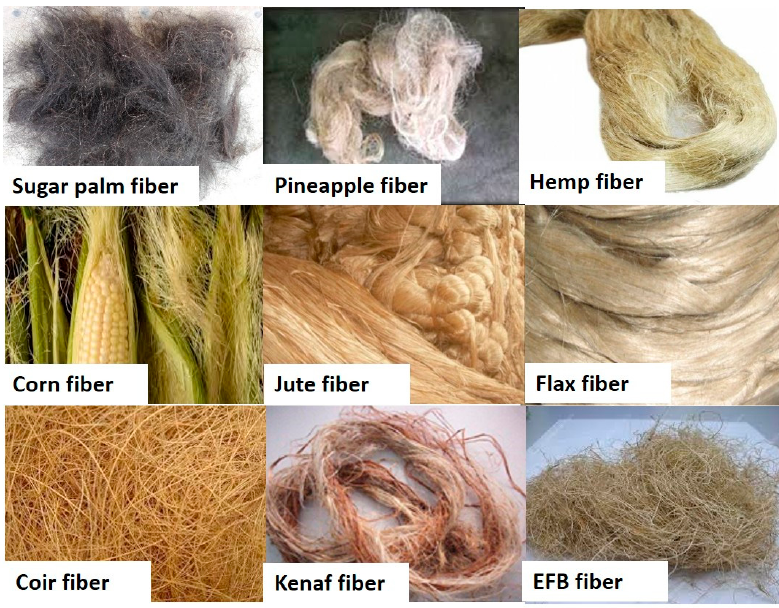
Figure 6. Various types of natural fiber.